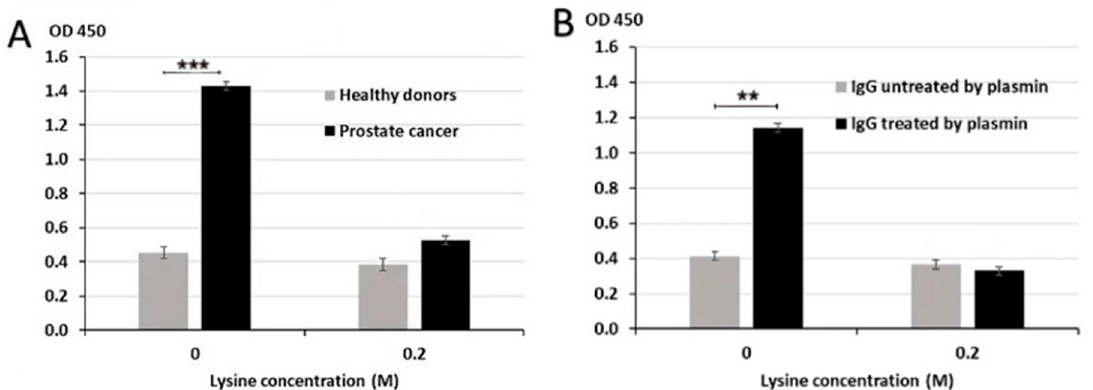
Figure 4. Inhibition of IgG/PLG-H binding by lysine. Lysine at 0.2 M inhibits binding of IgG to PLG-H in PC samples ( A ) and PM treated purified IgG samples ( B ) in a competition ELISA assay. The experiment was repeated 3 times **, p < 0.01; ***, p < 0.001.